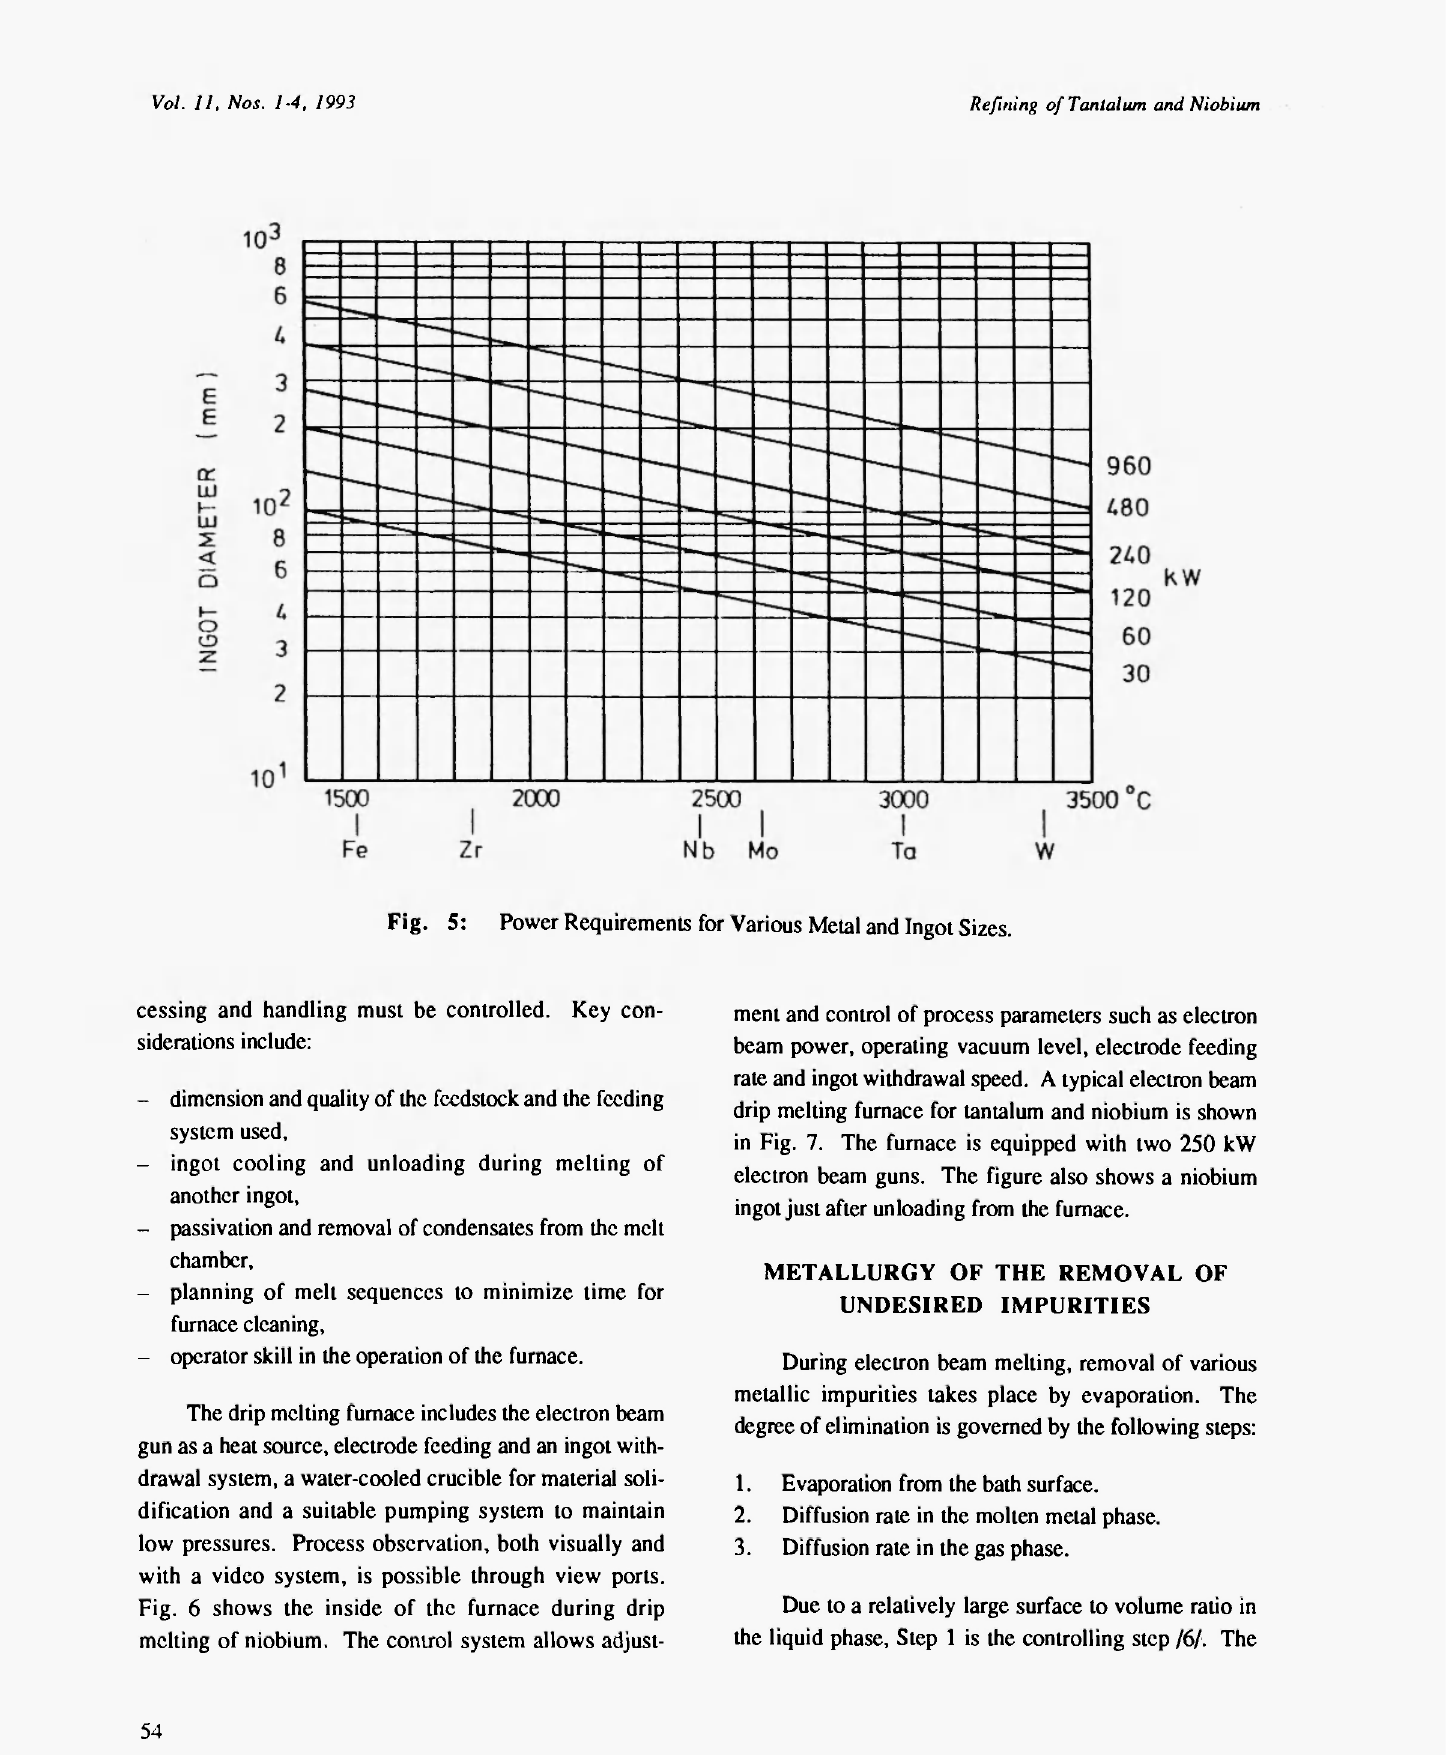
Fig. 5: Power Requirements for Various Metal and Ingot